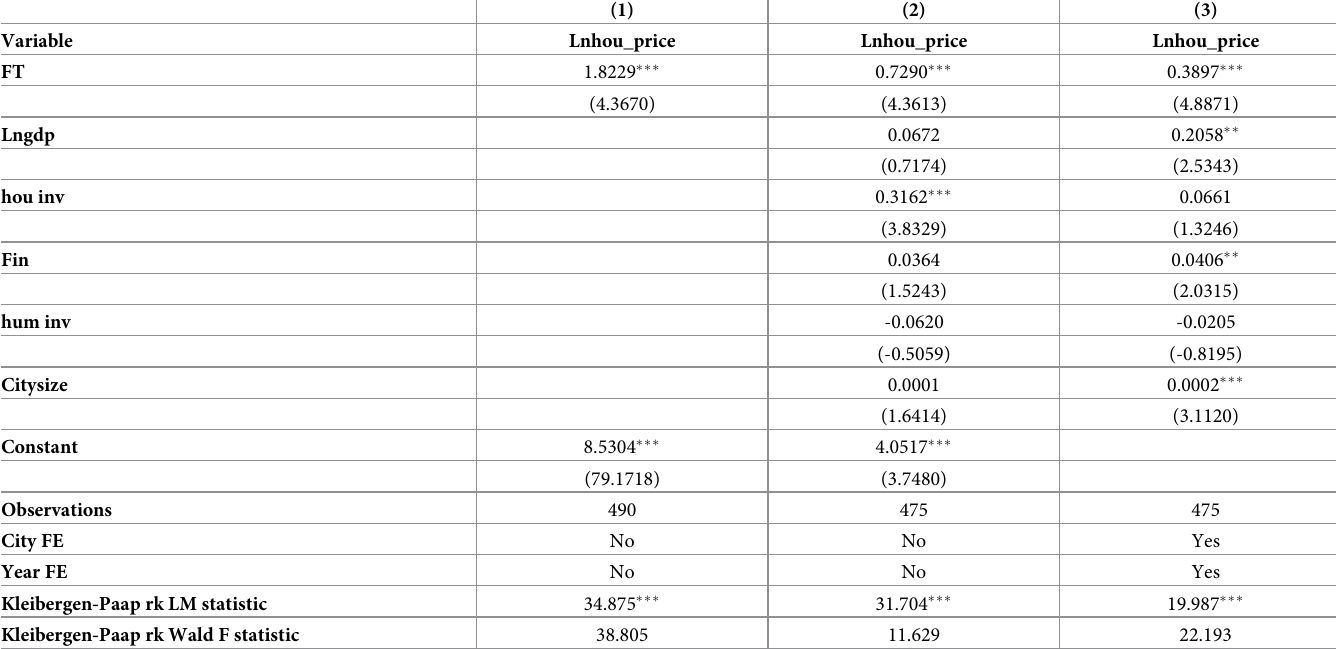
Table 7. Instrumental variable